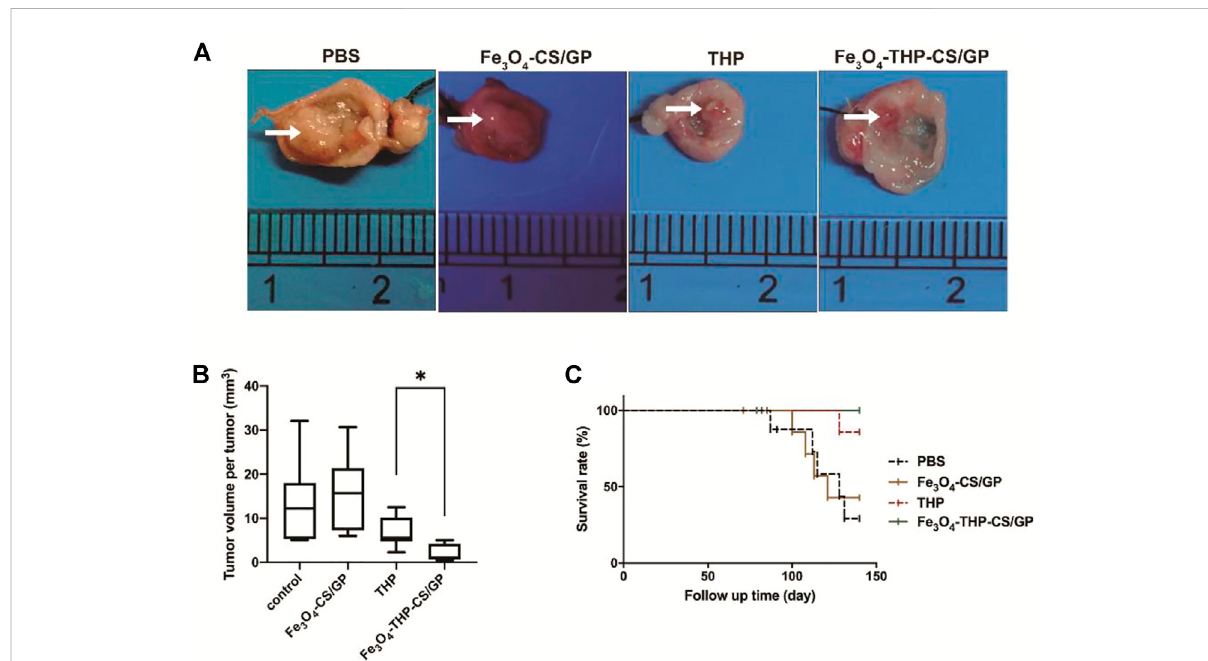
FIGURE 6 In vivo antitumor activity. (A) Representative images of bladder tumors in each treatment group. Relatively large bladder tumors are shown in groups treated with PBS and Fe 3 O 4 -CS/GP. Small tumors are observed in the group treated with free THP solution. The smallest tumors without progression are found in the group treated with Fe 3 O 4 -THP-CS/GP. (B) Summary of the tumor volume per tumor data. (C) Survival rates of the different groups upon tumor induction, p < 0.05. The white arrows indicate the tumors ( p <